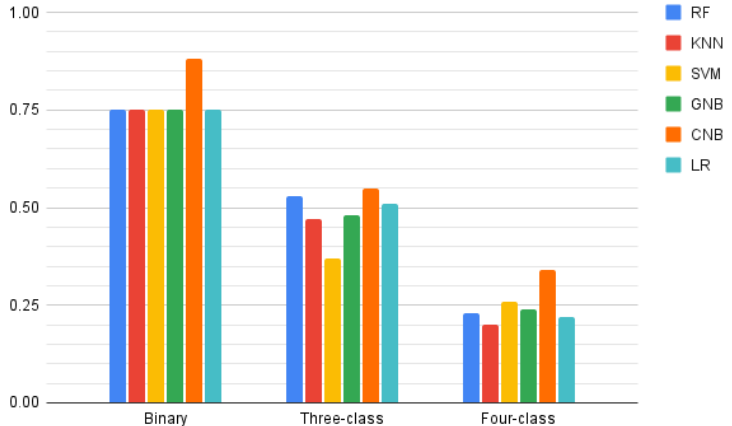
Figure 1. F1-scores for each Modified Fatigue Impact Scale classification type (binary, 3-classes, and 4-classes) for each model evaluated: random forest (RF), K-nearest neighbors (KNN), support vector machine (SVM), Gaussian naive Bayes (GNB), complement naive Bayes (CNB), and logistic regression (LR).